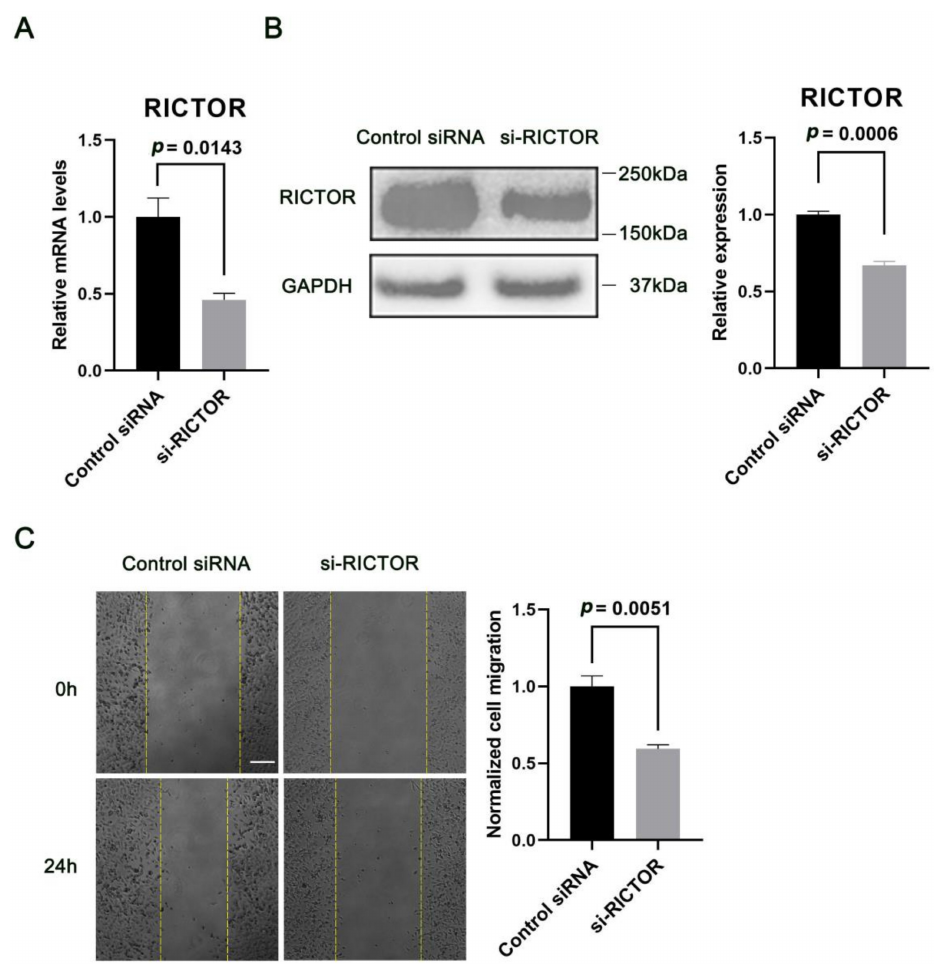
Figure 4. Down-regulation of RICTOR by siRNA and its effects on human neural cell migration. ( A , B ) Expression levels of RICTOR mRNA and protein in human SH-SY5Y cells. qRT-PCR and Western blotting were used to evaluate the mRNA and protein expressions 72 h after transfec- tion with control siRNA or siRNA cognate to RICTOR. ( C ) Knock-down of RICTOR inhibits the migration of human neural cells. The wound healing assay was conducted as described in Figure 3. Scale bar = 200 µ m. Error bar = SEM (standard error of the mean); n =